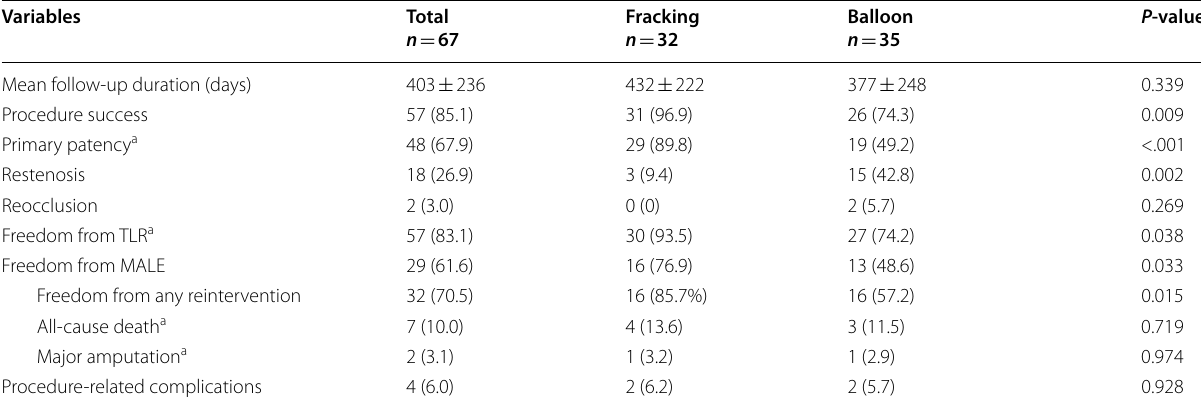
Continuous variables are indicated as mean standard deviation. Categorical variables are expressed as the counts (percentage) ± a The results were analyzed with Kaplan-Meier